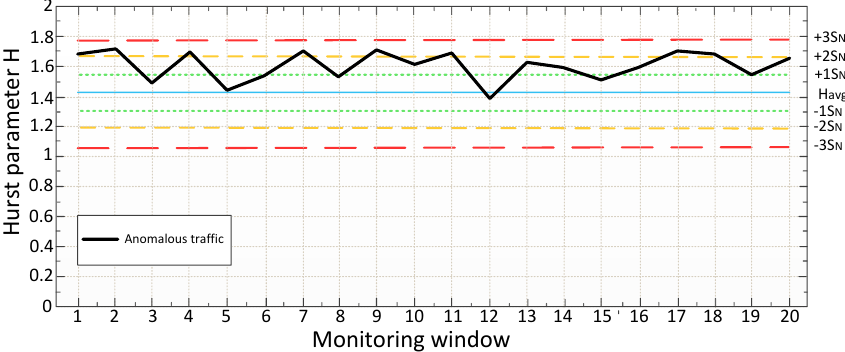
Figure 25. Values in 60 seconds with 3-second monitoring window for "anomaly" class (Non-Spoofed UDP Floods attack).